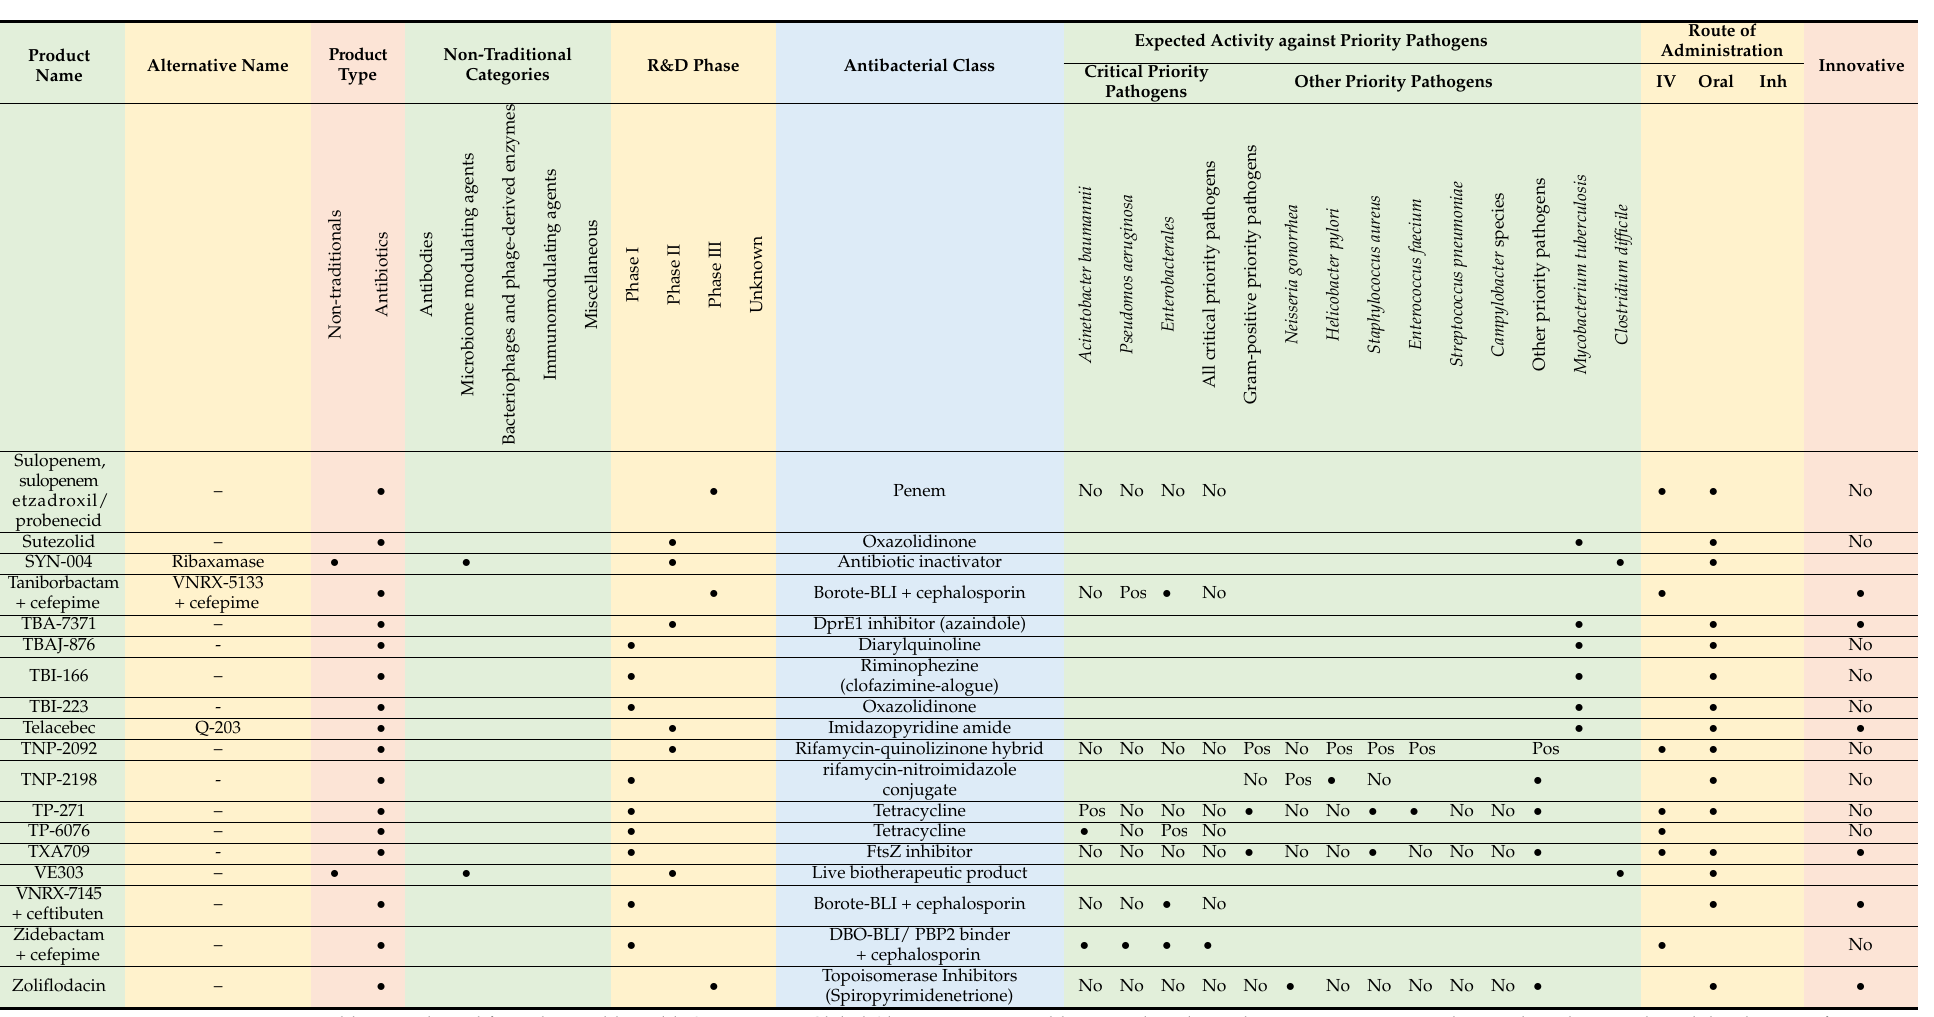
Table was adapted from the World Health Organization Global Observatory on Health Research and Development; section on antibacterial products in clinical development for priority pathogens; April 2021. Innovative: meets all four following criteria: new chemical class, new target or binding site, new mode of action, and/or no cross resistance to other antibiotic classes; na: Not absorbed; Pos: Possibly; Inh: